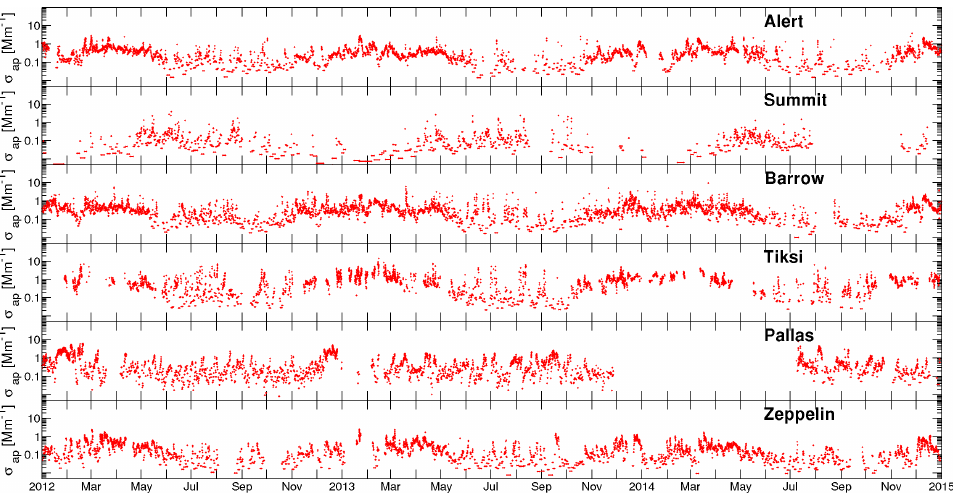
Figure 6. Time series of absorption coefficients using the adaptive collection time approach at a wavelength of 520nm. The attenuation coefficients have been corrected using the Arctic correction factor C f of